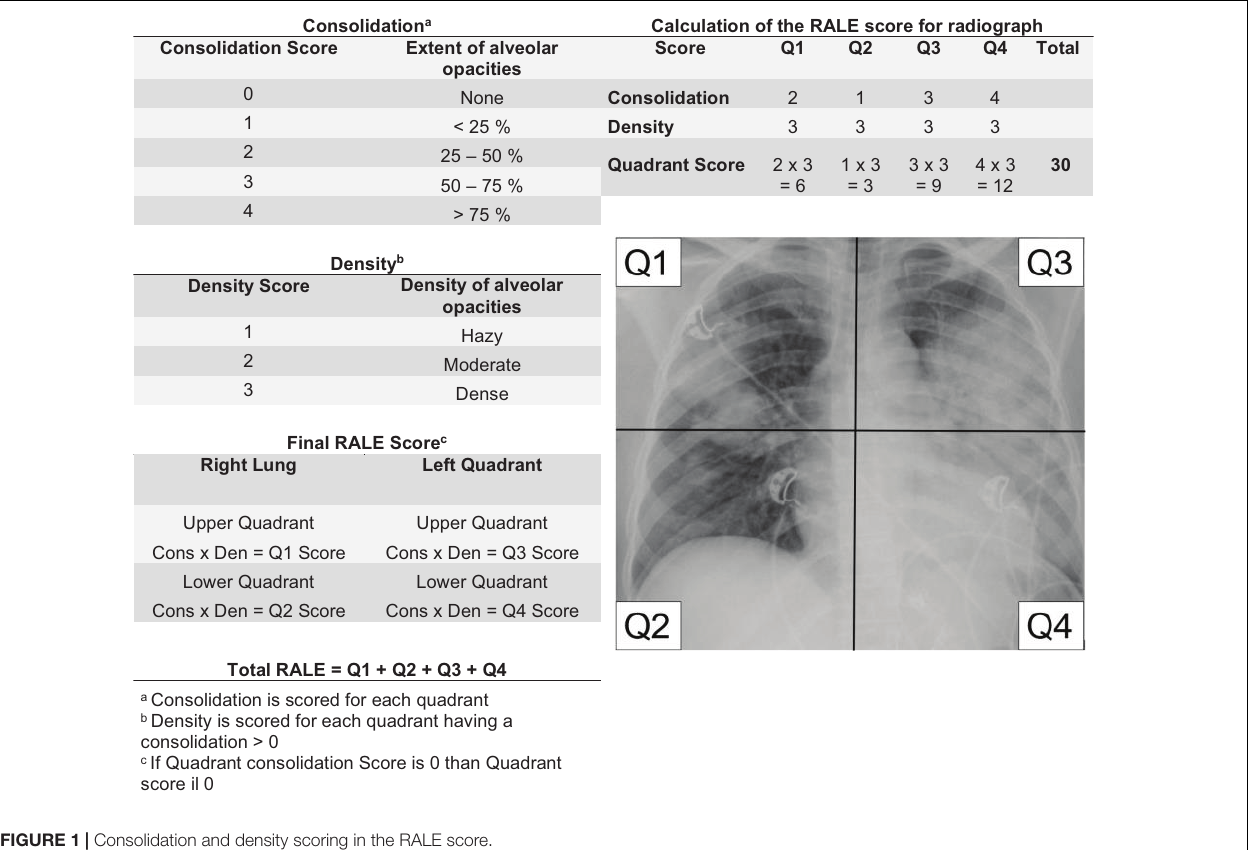
failure not fully explained by cardiac failure or fluid